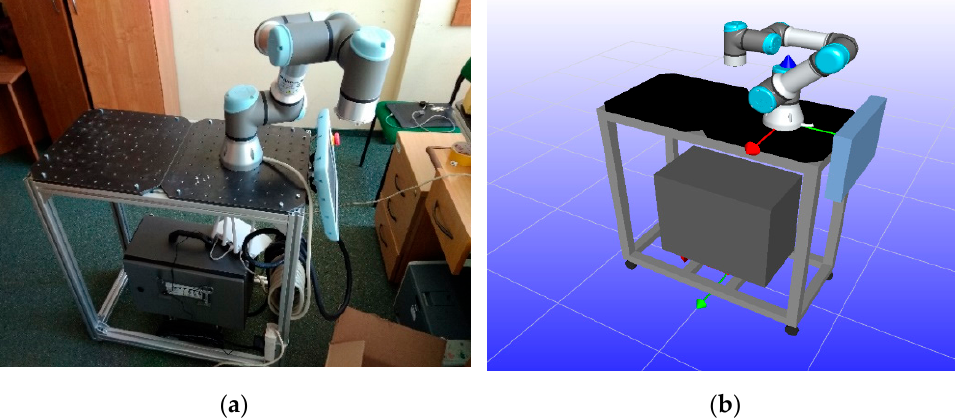
Figure 6. ( a ) UR3 robot; ( b ) RobWorkStudio environment used to visualize the robotic setup and control the robot trajectory. The coordinate system connected with the UR3 robot base is shown in the visualization ( b ).